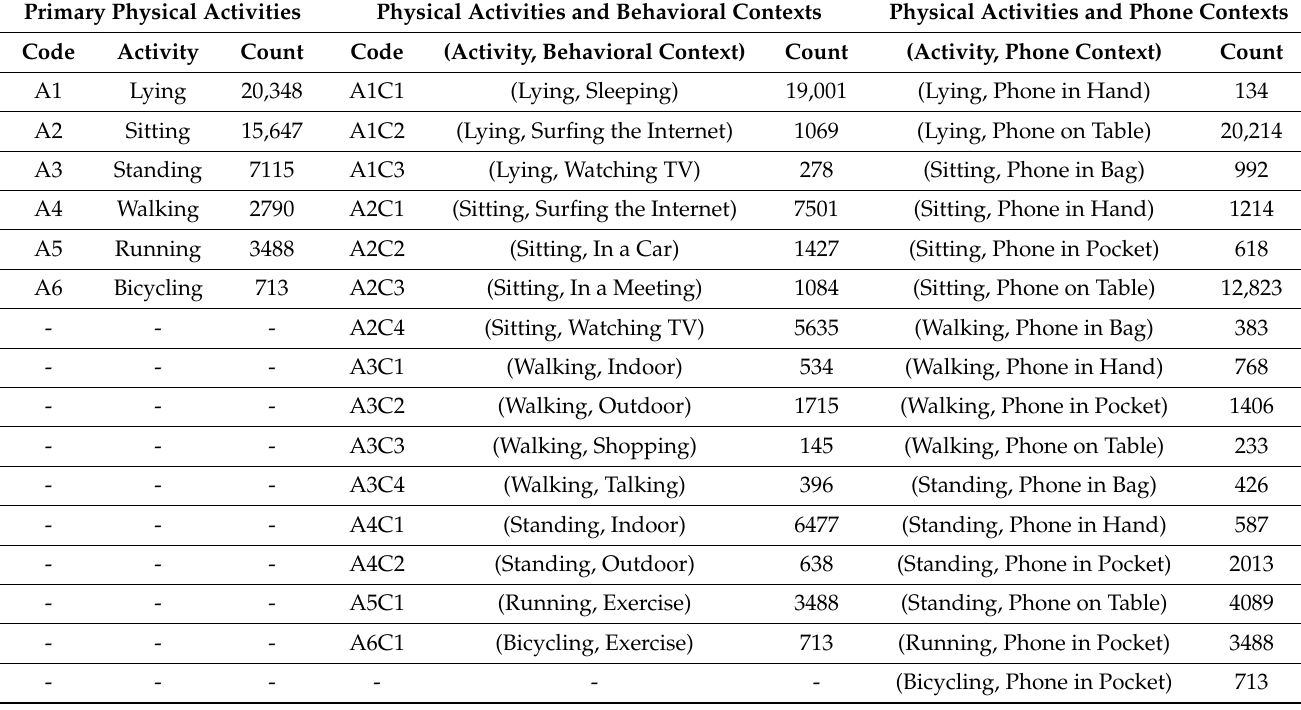
Table 1. List of primary physical activities and different activity-context pairs utilized for